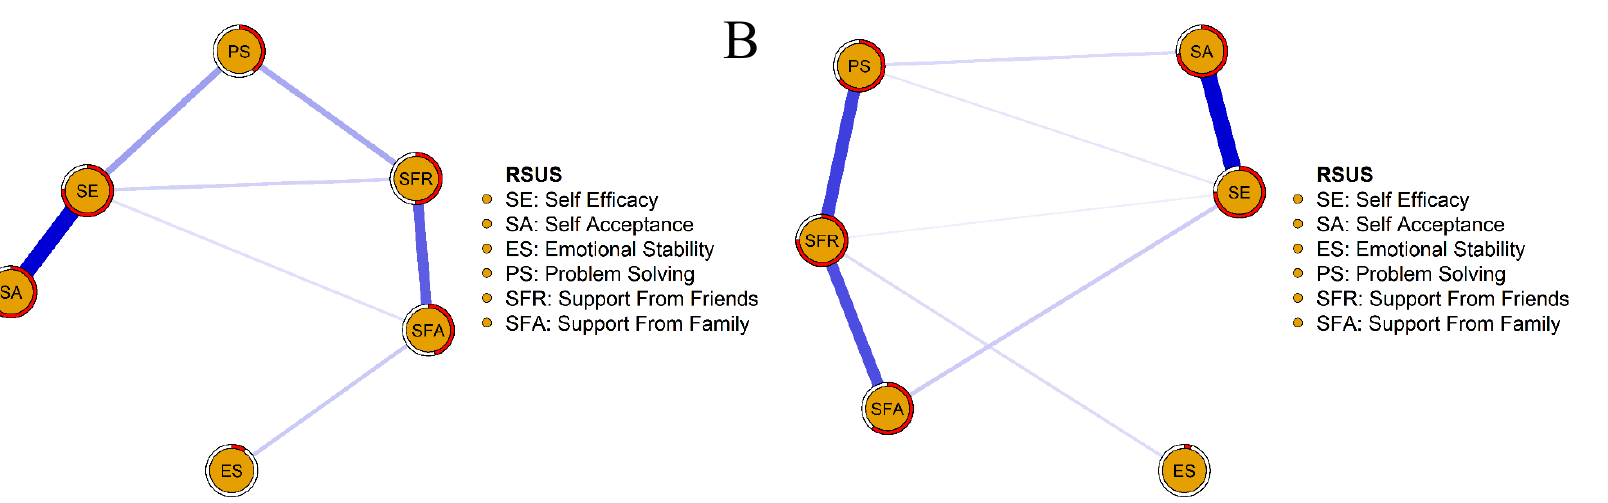
Figure 2. Network model for the six variables of resilience among wave 1 and wave 2. Note, positively worded items were reversed prior to the network estimation. ( A ), wave 1. ( B ), wave 2. The red circle represents the probability of a node being predicted by the surrounding connected nodes.